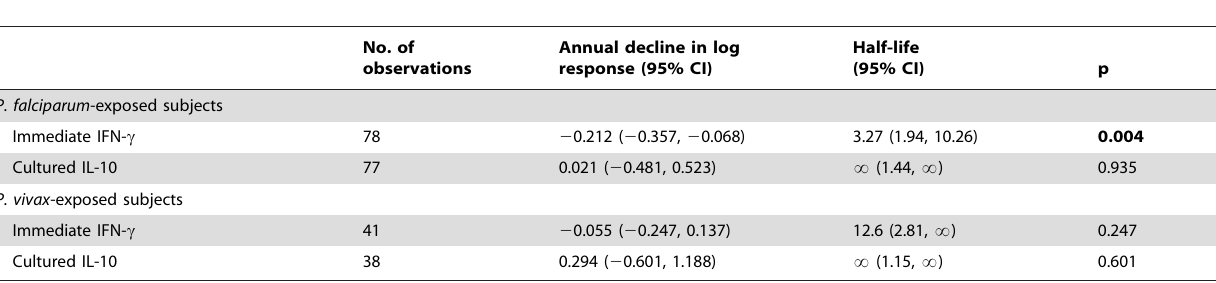
Table 2. Longevity of memory CD4 T cell responses to PfSE in P. falciparum - and P. vivax -exposed